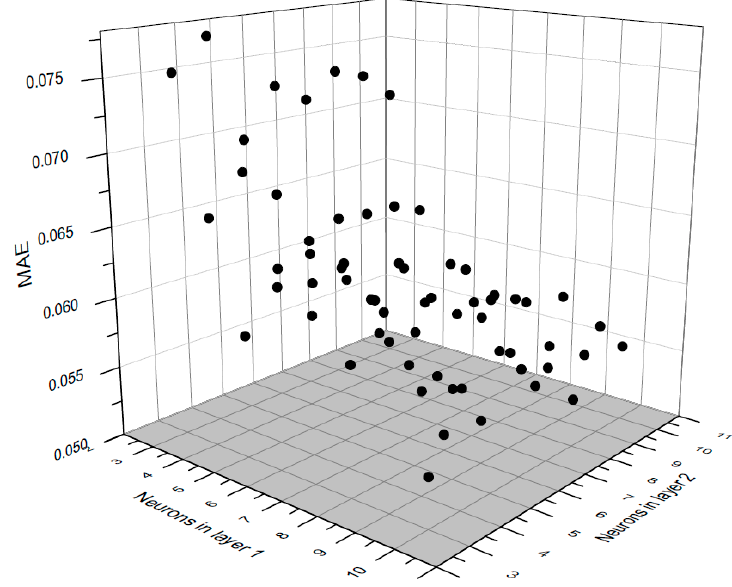
Figure 30. MEA versus hidden layers performance curve.